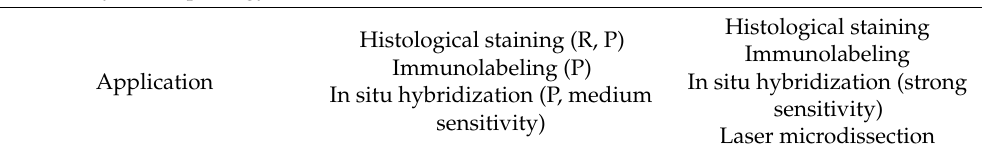
Table 1. Comparison of the different approaches. Resin (R)/Paraffin (P)-Section Cryo-Section Section preparation Long method Short method Toxic substances Long period Short period Size of the section 5 µ m 5 µ m Quality of morphology Good Medium Histological staining Histological staining (R, P) Immunolabeling Immunolabeling (P) Application In situ hybridization (strong In situ hybridization (P, medium sensitivity) sensitivity) Laser